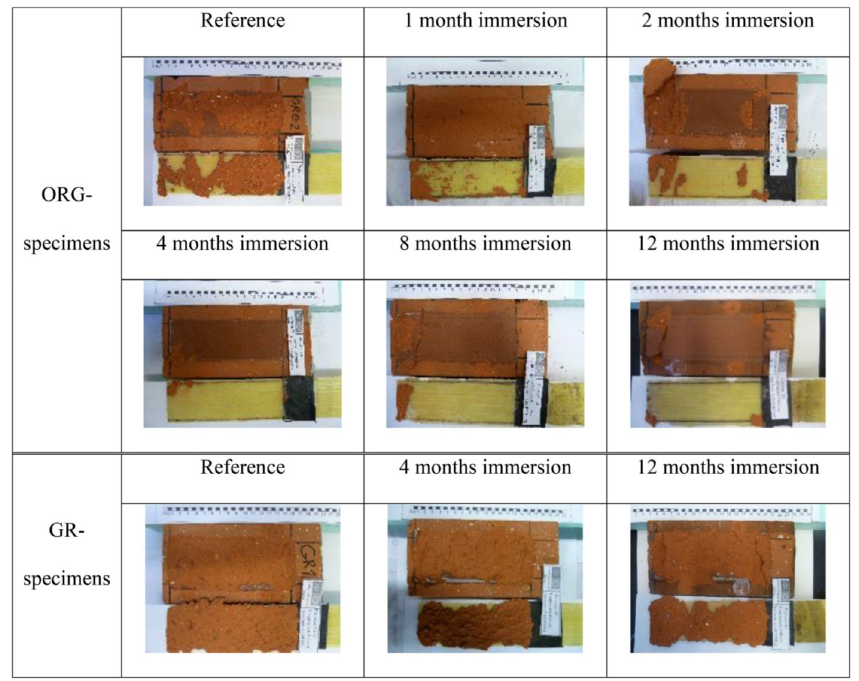
Figure 4. Failure mode changes with water immersion [8]; specimens prepared by wet layup procedure on grinded surfaces (GR) or without mechanical surface treatment (OGR). Reprinted from Composites Part B, 87, Maljaee H., Ghiassi B., Lourenço P.B., Oliveira D.V., Moisture-induced degradation